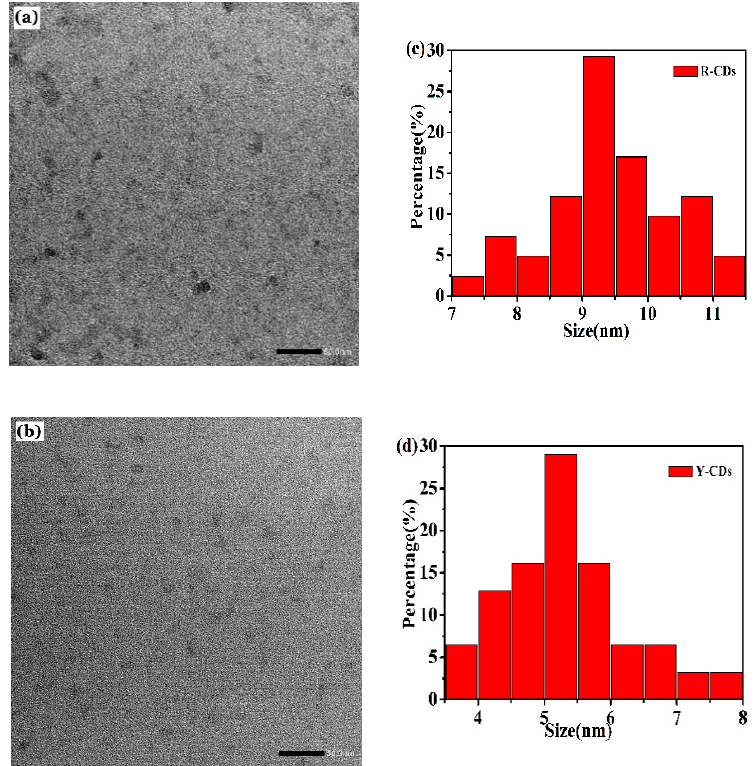
Figure 5. ( a ) and ( b ) are TEM images of R-CDs and Y-CDs, respectively. ( c ) and ( d ) are the particle size distributions of R-CDs and Y-CDs, respectively.